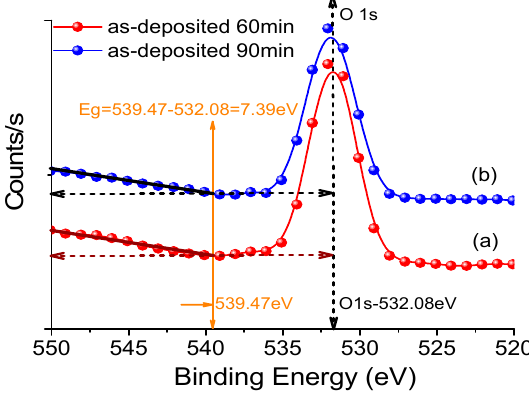
Figure 11. The band gap of Al 2 O 3 from the O 1s peak obtained by high resolution XPS.